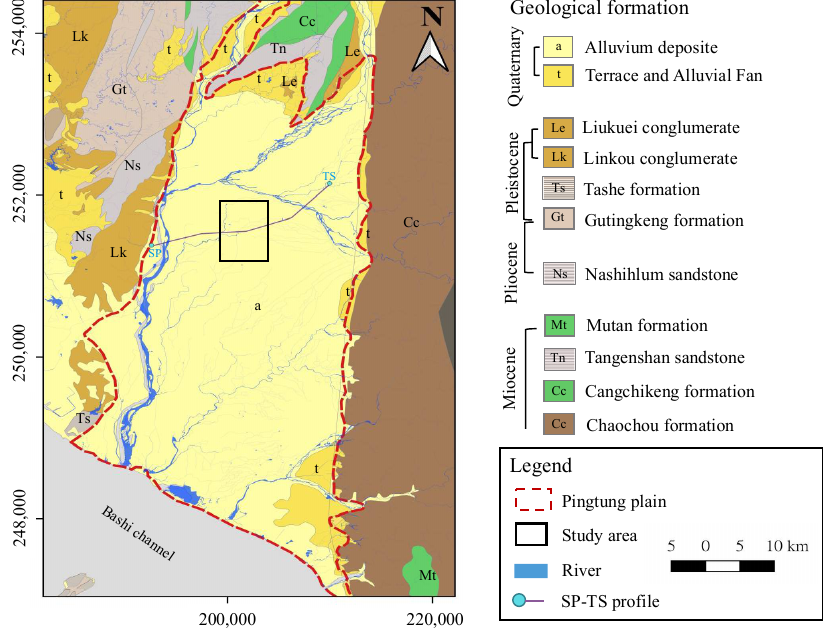
Figure 1. The geological map of the Pingtung plain after the Central Geological Survey [23]. The rectangular square represents the study area and the circle with a line is SP–TS hydrogeological profile.